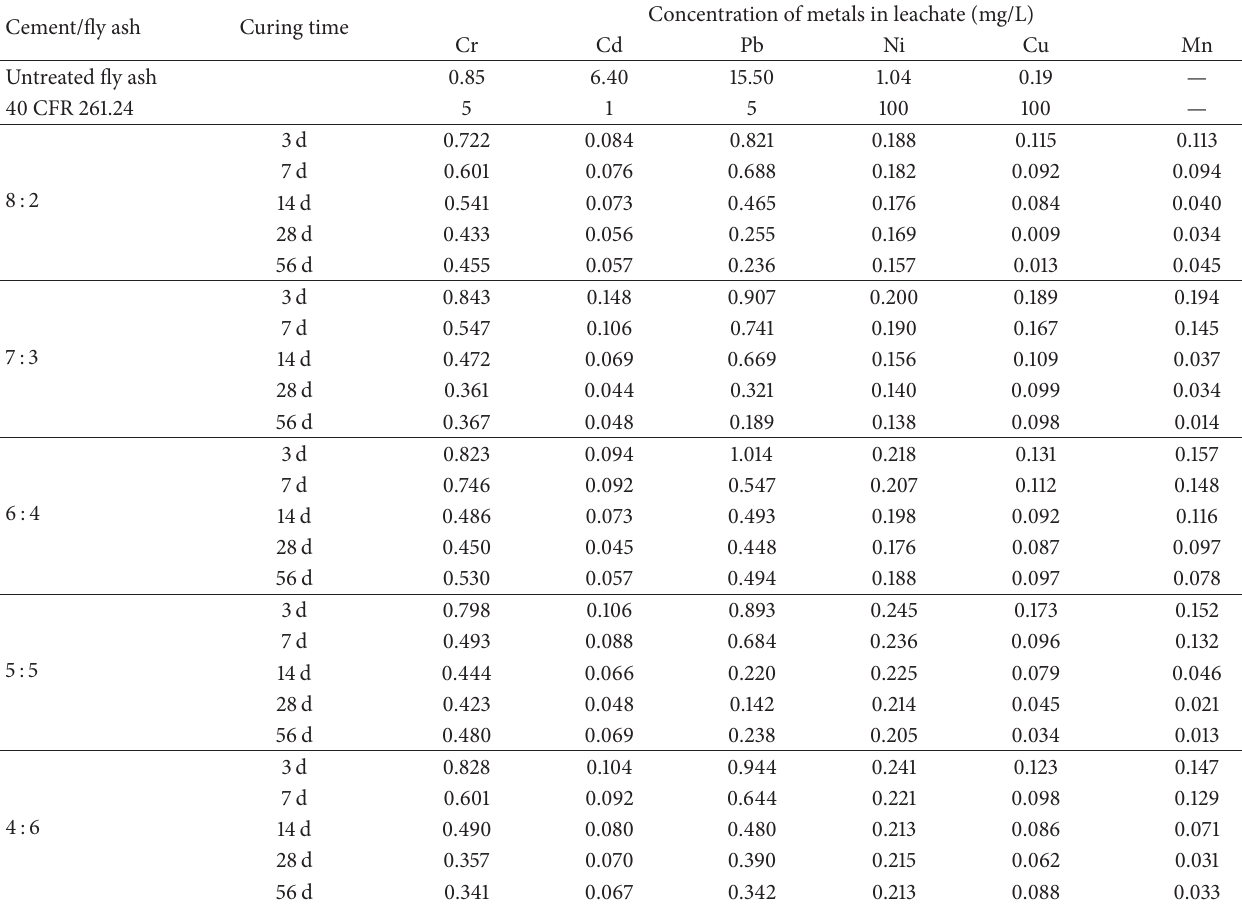
Table 4: Summary of TCLP leaching results for solidified fly ash